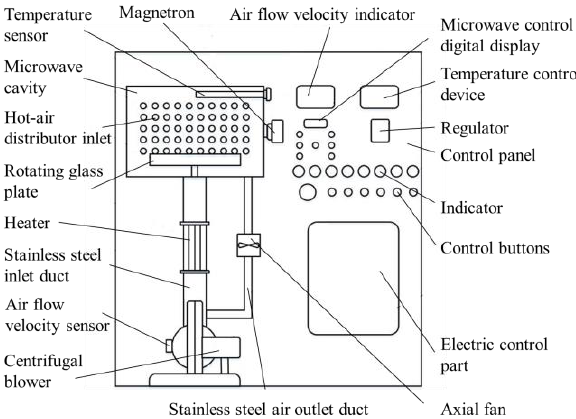
Figure 1. Schematic diagram of microwave coupled with hot air (MWHA) dryer.